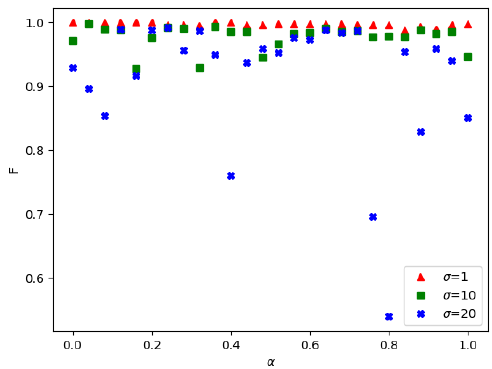
Figure 2. Comparison of fidelity when N = 1000.